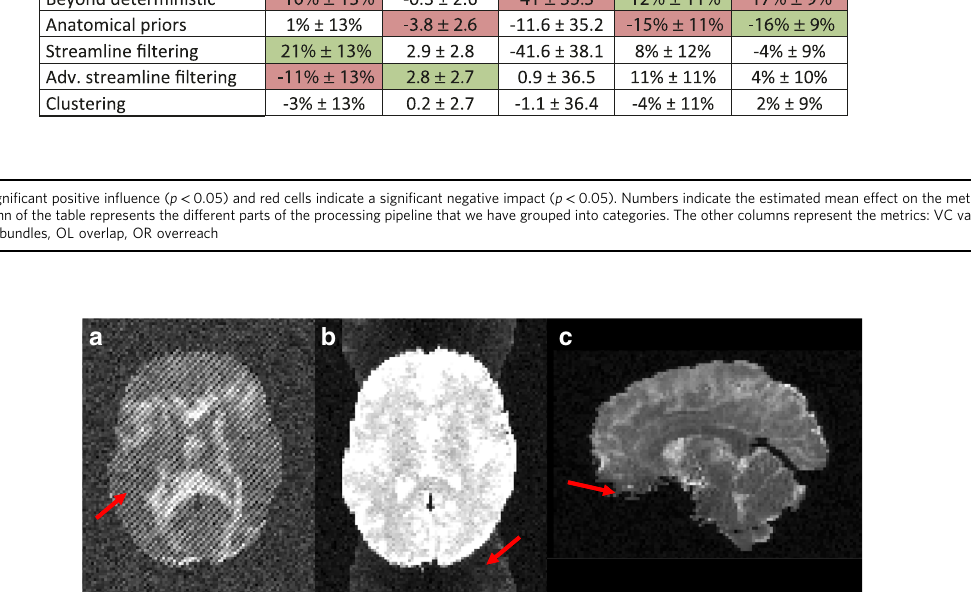
Fig. 9 Illustration of artifacts included in the synthetic data set. Exemplary illustration of the spike ( a ), N/2 ghost ( b ), and distortion artifacts ( c ) contained in the fi nal diffusion-weighted data set. Supplementary Movie 3 gives an impression of the complete synthetic data set provided